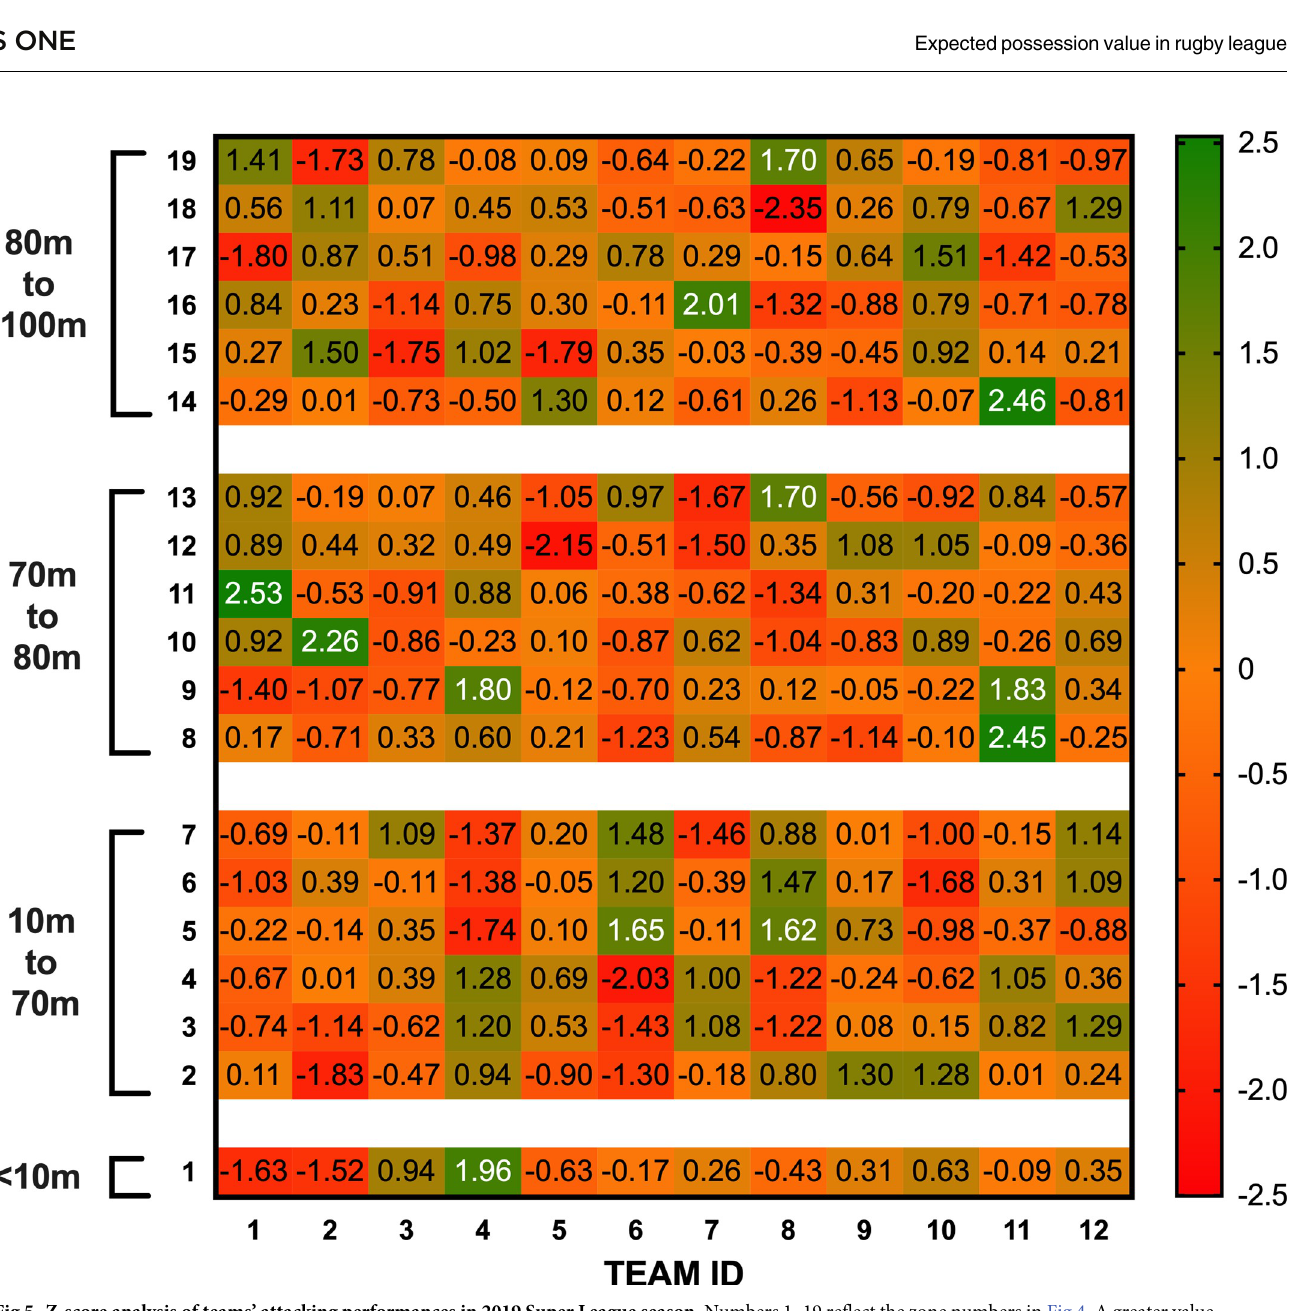
Fig 5. Z-score analysis of teams’ attacking performances in 2019 Super League season. Numbers 1–19 reflect the zone numbers in Fig 4. A greater value indicates a greater proportion of EPV was obtained from the zone than the average Super League 2019 team. Distances are measured from the team’s own try line.